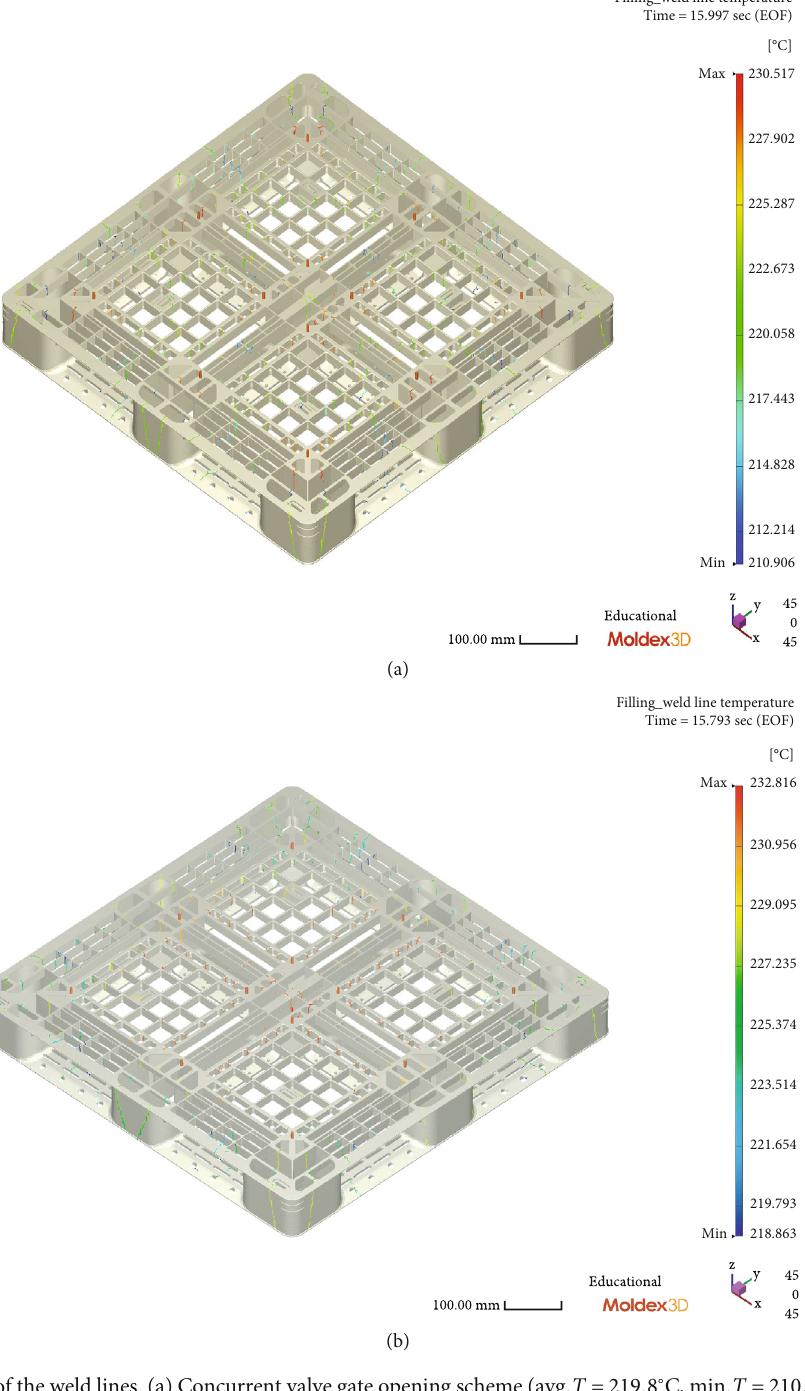
Figure 9: Temperatures of the weld lines. (a) Concurrent valve gate opening scheme ( avg : T = 219 : 8 ° C , min : T = 210 : 9 ° C ). (b) Sequential gate opening scheme ( avg : T = 227 : 3 ° C , min : T = 221 : 3 ° C